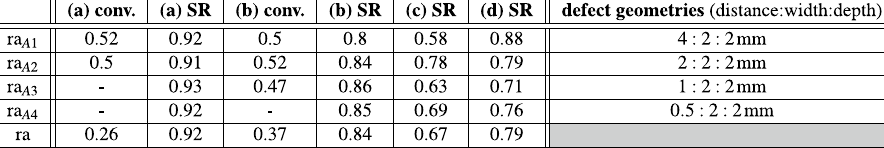
0, 1 0.25 ra A 2 ra A 3 ra A 4 ) for each ( ra A 1 with ra ∈ [ ] = · + + +